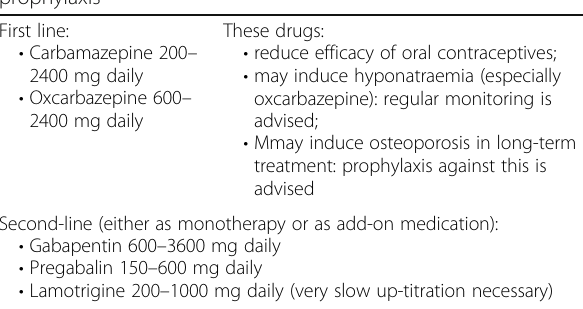
Table 16 Drugs used by specialists in trigeminal